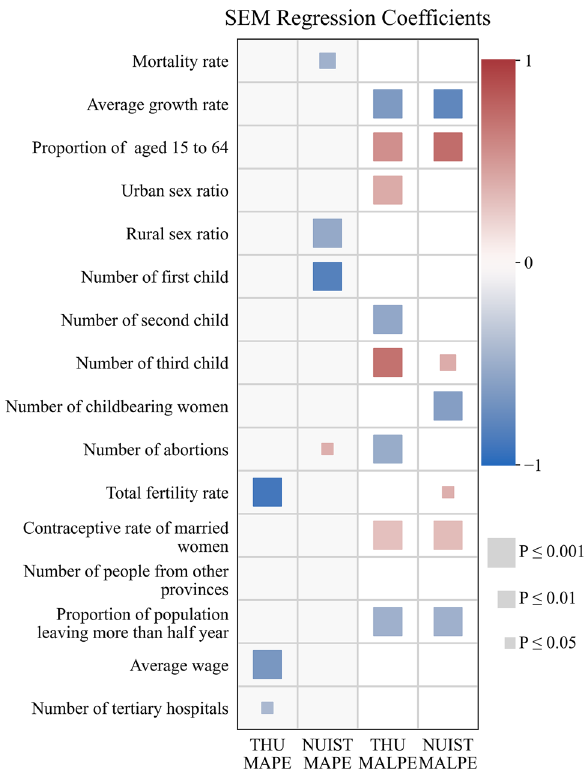
Figure 6. Regression coefficients of the SEM for the MAPE and MALPE of NUIST and